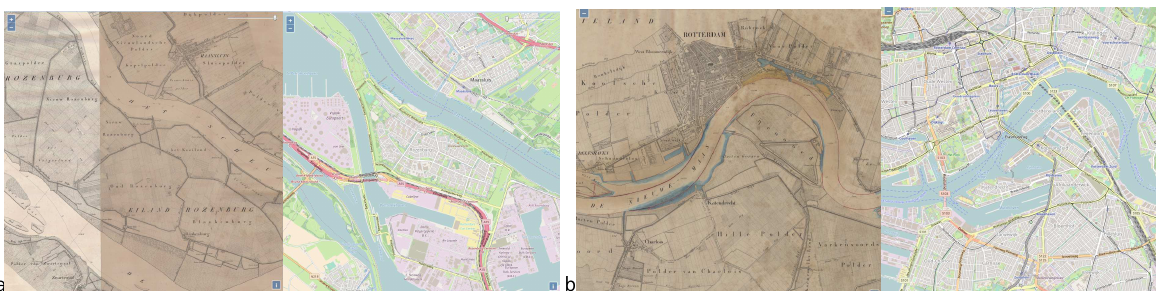
Figure 7. The Rhine at the estuary of (a) and in correspondence of Rotterdam (b) before the Nieuwe Waterweg dig (left) and currently